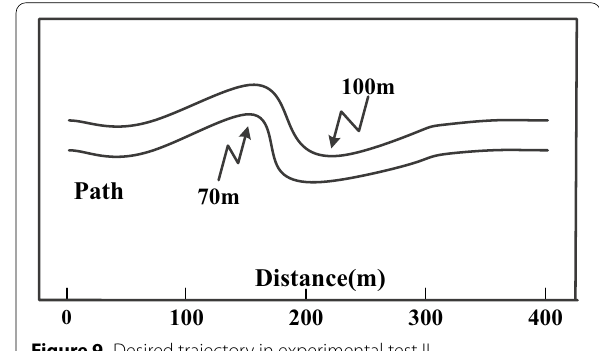
Figure 9 Desired trajectory in experimental test II